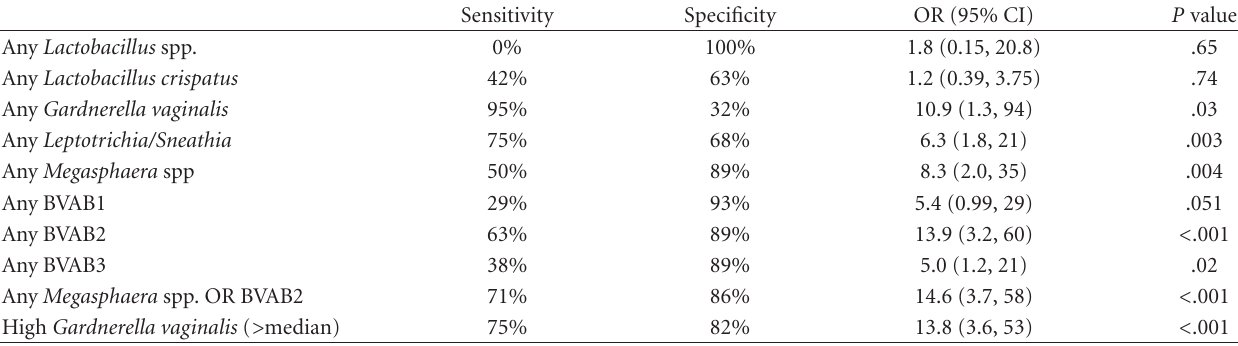
Table 3: Sensitivity and specificity of detection of individual and combinations of bacteria for diagnosis of bacterial vaginosis compared to Amsel’s clinical criteria.